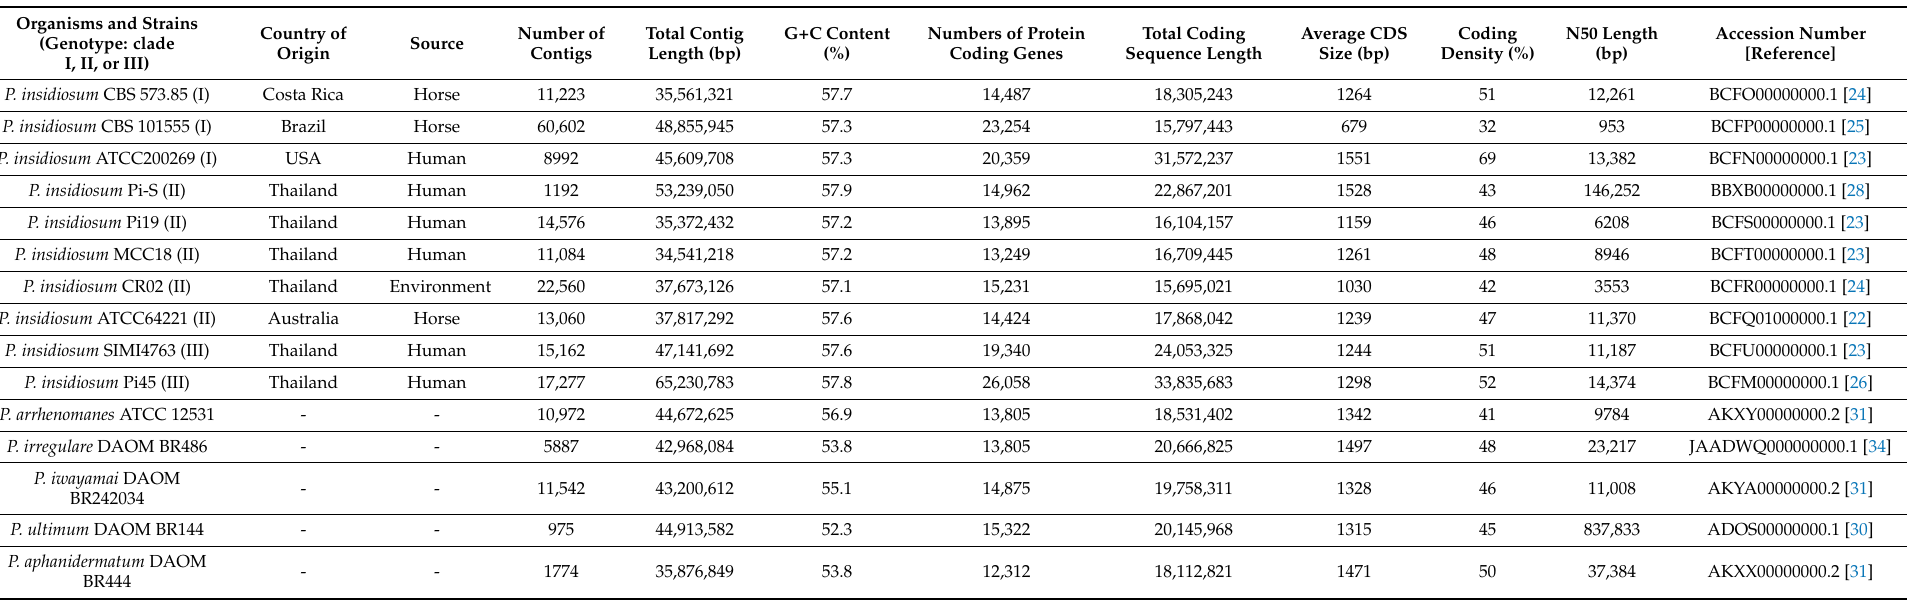
Table 1. Genome summary of 10 P. insidiosum strains and 5 other Pythium species (i.e., P. irregulare , P. ultimum , P. iwayamai , P. aphanidermatum , and P. arrhenomanes ) used in this